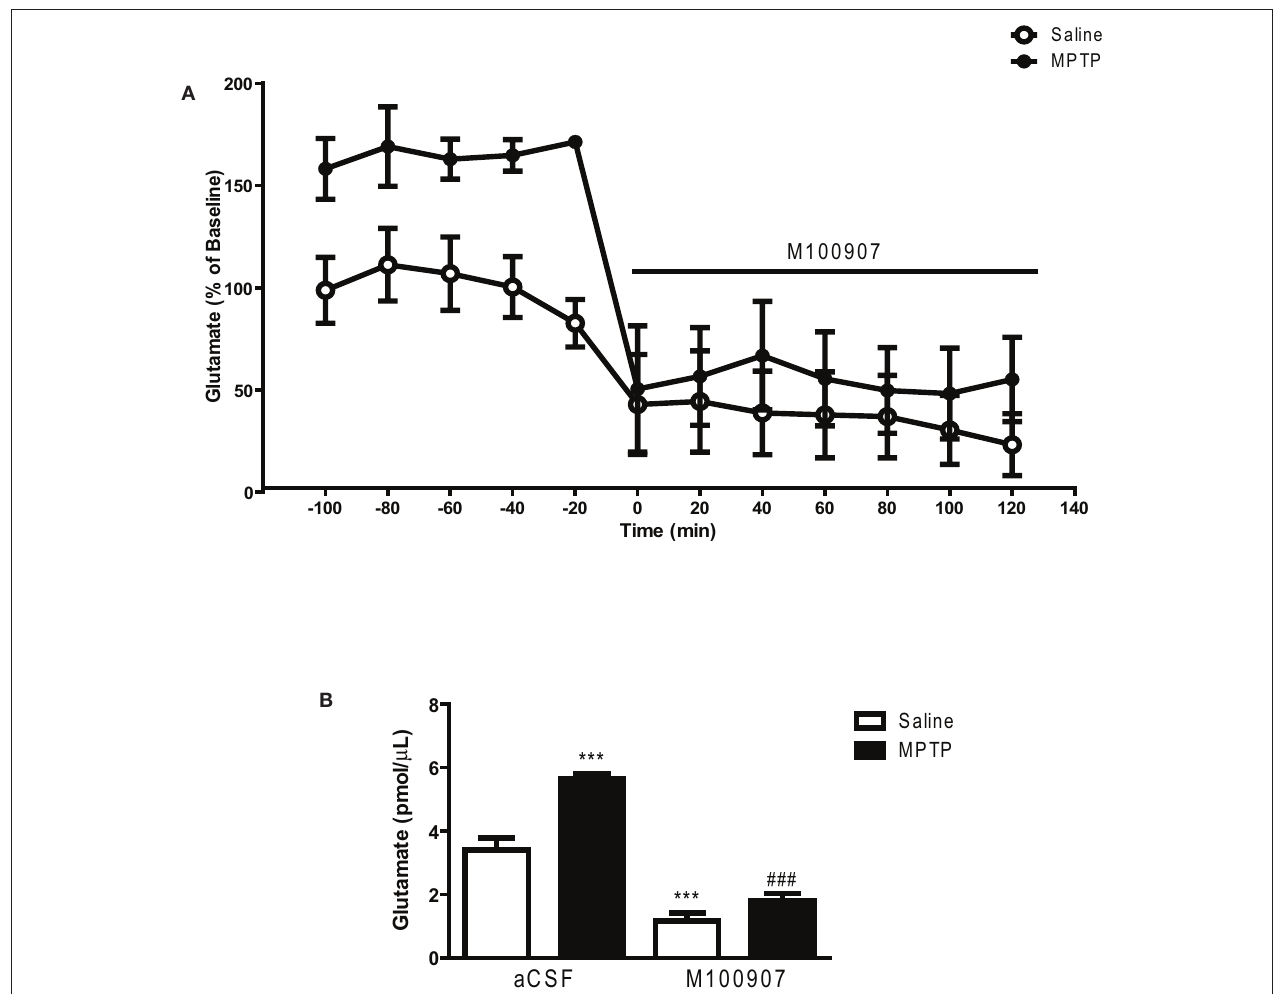
and an additional seven samples were collected. (B) The effects of M100907 on extracellular glutamate values of saline and MPTP-treated mice. *** p < 0.001 compared with saline-injected control mice; ### p < 0.001 when compared with MPTP-treated mice. The line segment on time course graphs indicate duration of